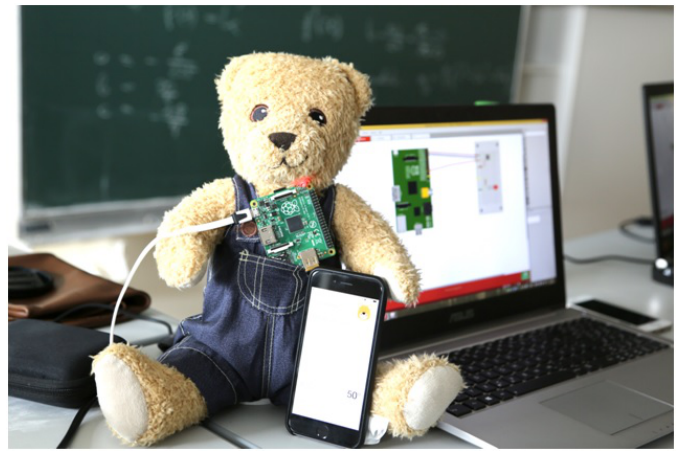
Fig. 1. Sensitive cuddly